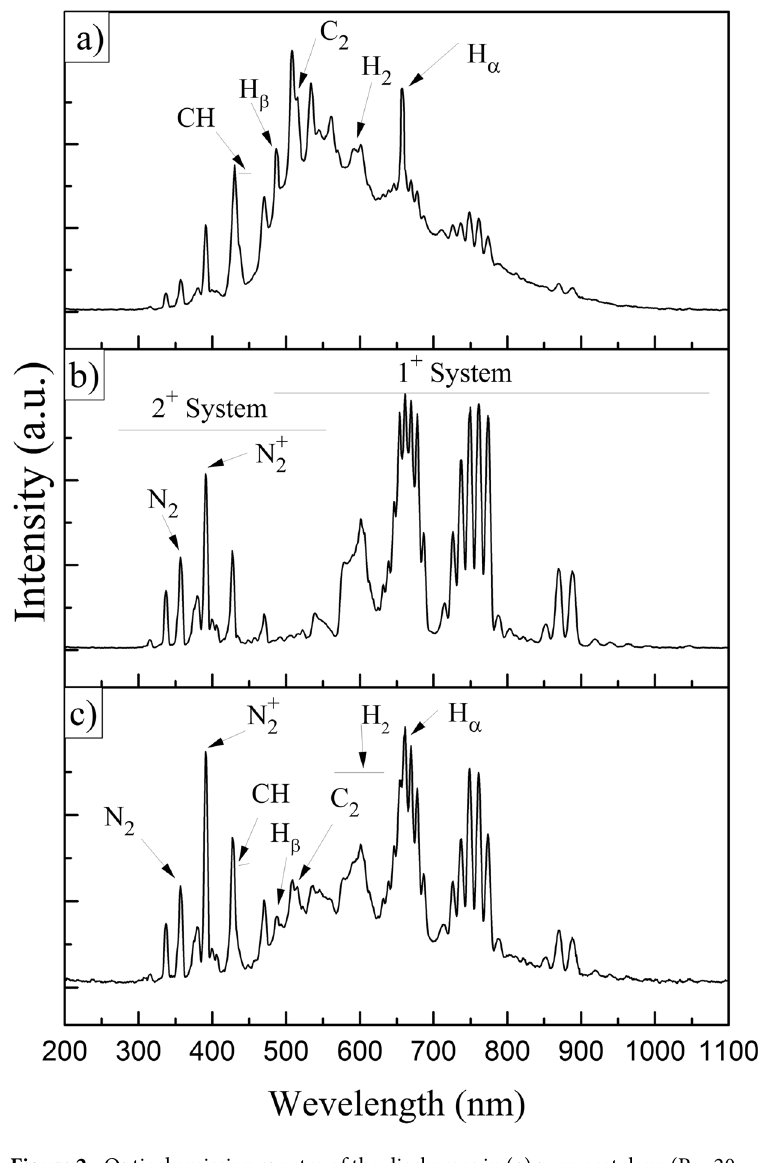
Figure 2. Optical emission spectra of the discharges in ( a ) pure acetylene (P = 20 w, 20 sccm flow rate), ( b ) pure nitrogen (P = 20 w, 40 sccm flow rate), and ( c ) gas mixture (P = 20 w, R = 2).